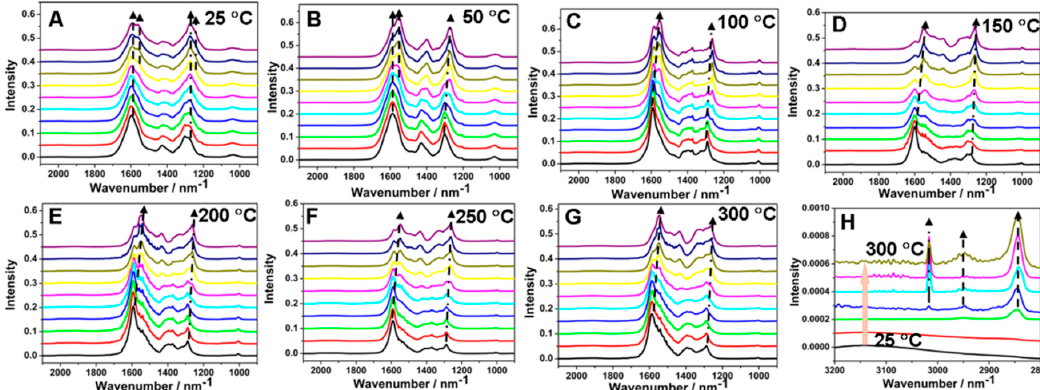
Figure 13. Operando DRIFT spectra recorded over Ru/CeO 2 catalyst by introducing 13CO 2 and H 2 as reaction gas after 90 min of equilibrium reaction in 12CO 2 and H 2 . From bottom to top in each panel: 0, 0.5, 1, 1.5, 2, 3, 5, 7, 10, and 15 min. From A to G : 25, 50, 100, 150, 200, 250, and 300 °C. ( H ) The DRIFT spectra of CH 4 recorded over Ru/CeO 2 catalyst after 90 min of equilibrium reaction in 12CO 2 and H 2 . From bottom to top: 25, 50, 100, 150, 200, 250, and 300 °C. Reprinted with permission from Reference [64]. Copyright 2016, American Chemical Society.